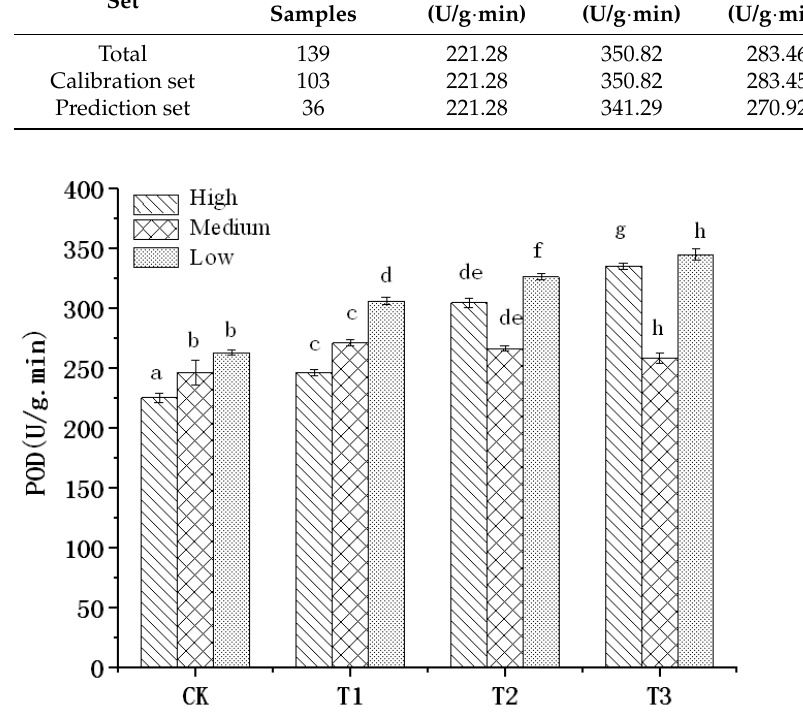
Figure 2. Changes of POD activity under salt stress. The a–h indicates significant differences by analysis of variance.